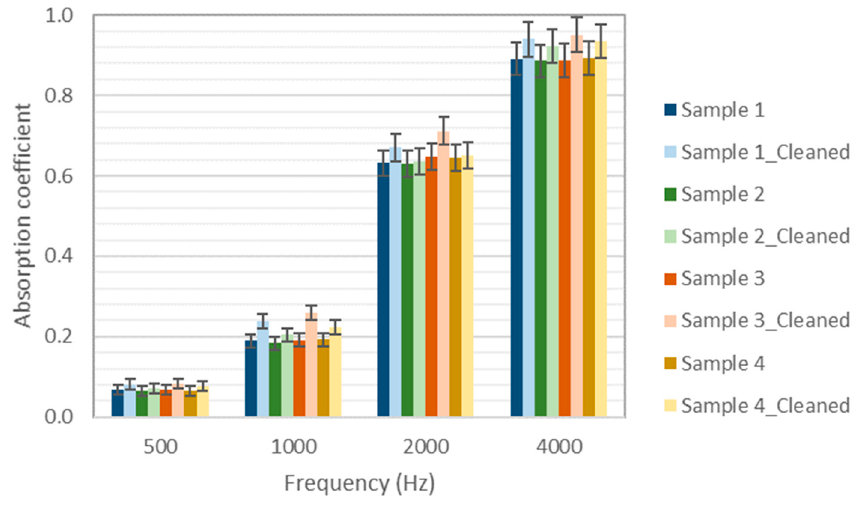
Figure 10. Effect of chemical cleaning on the absorption coefficient values (octave